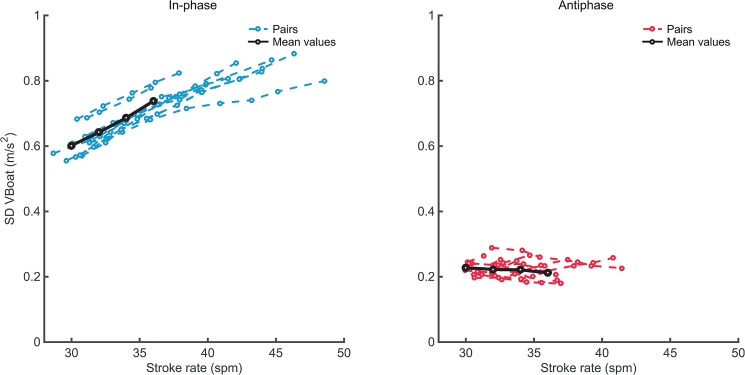
Variability of ‘boat’ velocity.Values for in-phase (left panel) and antiphase (right panel) crew coordination depicted against performed stroke rates for all eleven dyads. Black lines indicate the means over the eight dyads as used in the RM ANOVA for stroke rates 30–36.